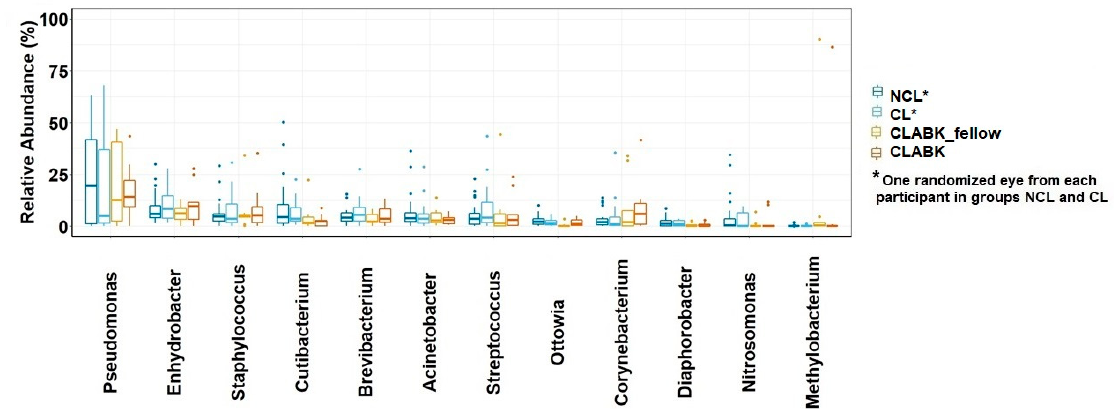
Figure 2. Relative abundance (%) of the 12 most common genera of ocular surface microbiota in the whole study population. Boxplots for relative abundance with medians and interquartile range (IQR) are shown for non-contact-lens users (NCL), contact lens users without bacterial keratitis (CL), fellow eye of patients with contact-lens-associated bacterial keratitis (CLABK_fellow) and for eyes with bacterial keratitis (CLABK). Data from one randomized eye of each participant in the NCL and CL groups were compared with data from CLABK_fellow and CLABK. No significant difference was demonstrated with the Kruskal–Wallis test (p adj > 0.05) for NCL vs. CL/CLABK_fellow or for NCL vs. CL/CLABK.